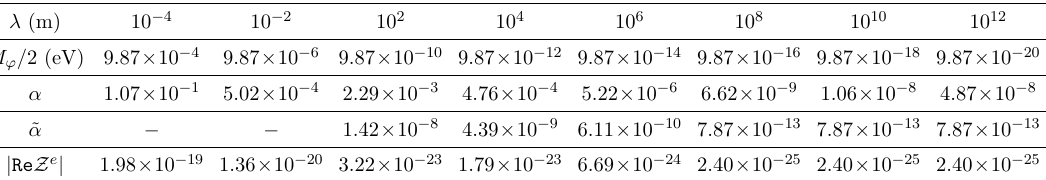
Table 1 . Limits on the coupling strength between matter and a scalar particle ’ , M ’ = ( ~ c ) =(cid:21) , adapted from refs. [17, 18]. For M ’ < 1 : 55 (cid:2) 10 (cid:0) 14 eV, the limits on ~ (cid:11) and j Re Z e j are dominated by the results of the MICROSCOPE experiment [19]. The scalar interaction is assumed to a(cid:11)ect elec- trons only. To extract the bounds on Z e , we have chosen the representative value Z 1 Z 2 =A 1 A 2 = 0 : 2. Typical values of the parameter Z Z =A A are between 0.16 and 0.22. In table 1 we show 1 2 1 2 the present bounds [17] on (cid:11) and ~ (cid:11) for some values of (cid:21) and the corresponding limit on Z e , taken as the most restrictive